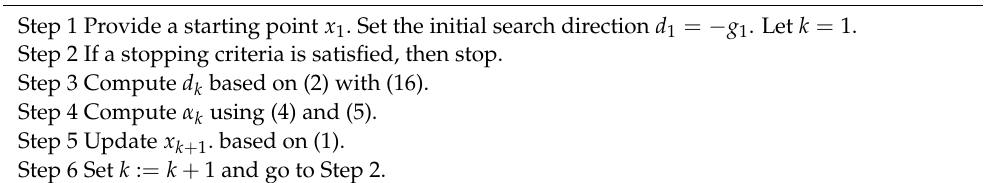
Algorithm 1. The steps to obtain the optimum point of optimization problem by using the CG